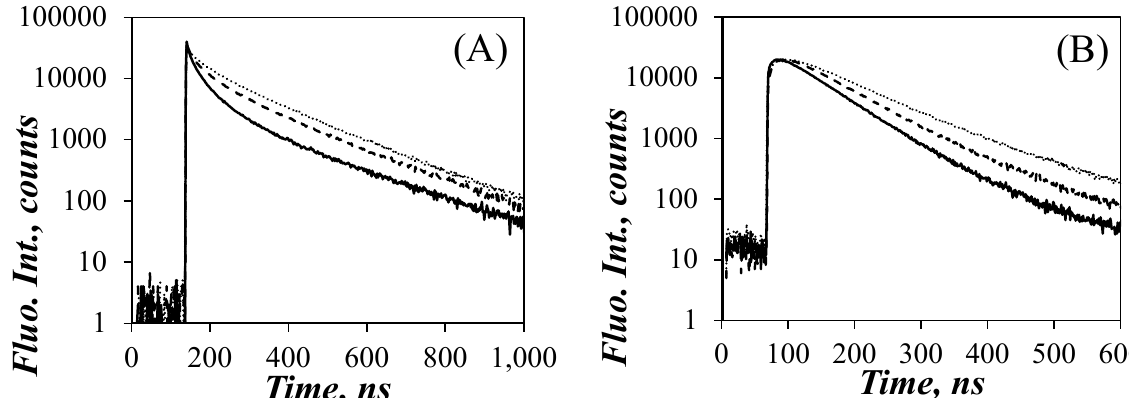
Figure 3. Fluorescence decays of the pyrene ( A ) monomer and ( B ) excimer of the Py(9.0)-P L GA solutions in DMF at different GdHCl concentrations. From bottom to top: [GdHCl] = 0.1, 1.0, 5.0 mol · L − 1 yielding N blob values of 19, 15, and 11, respectively.